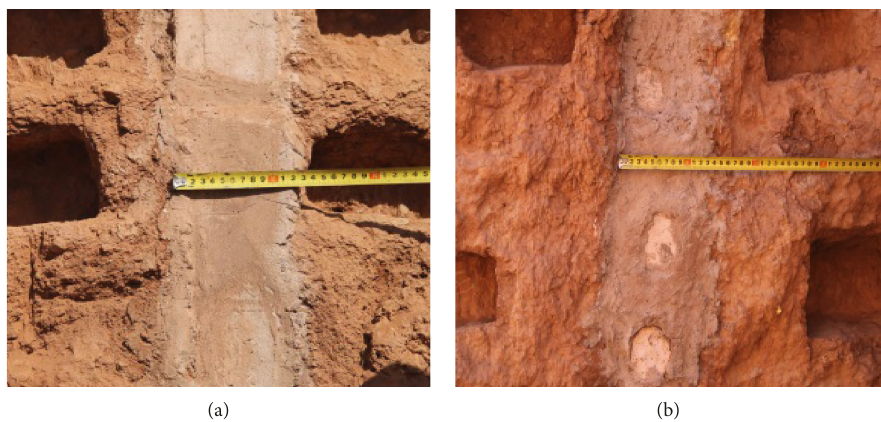
Figure 5: Macroscopic shapes of the fissure after grouting: (a) traditional and (b) optimized.